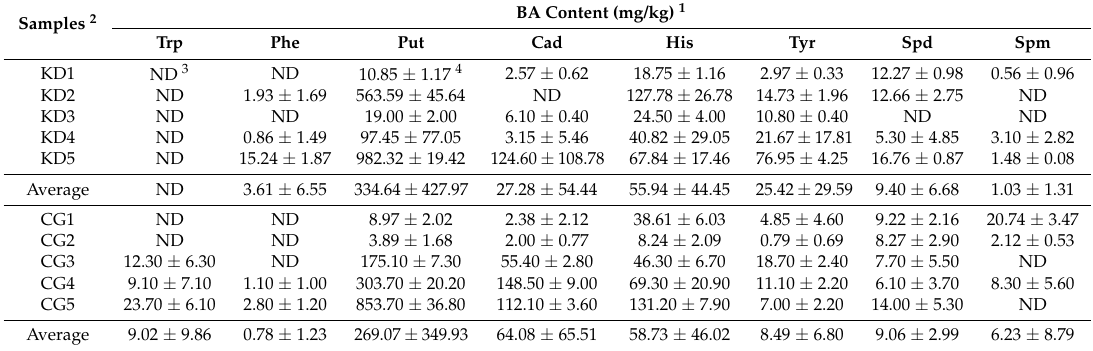
Table 2. BA content in two types of radish kimchi samples: Kkakdugi and Chonggak kimchi. Samples